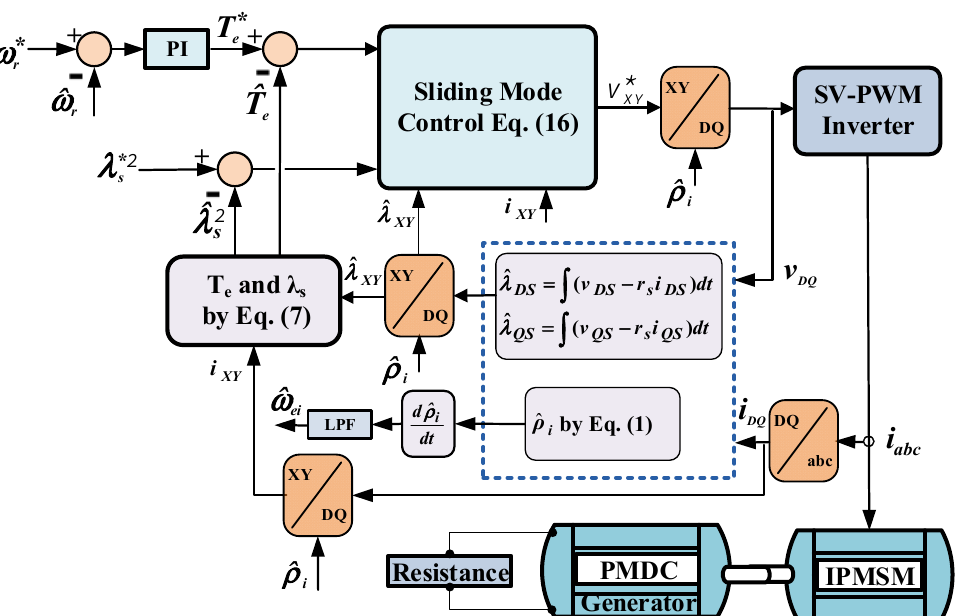
Figure 5. Block diagram of proposed IPMSM drive system control.